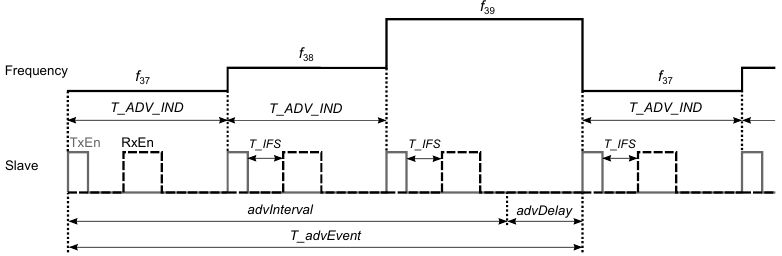
Figure 11. Advertising event of length T _ advEvent and consisting of three advertising packets (TxEn is set high) sent on 3 primary advertising channels.